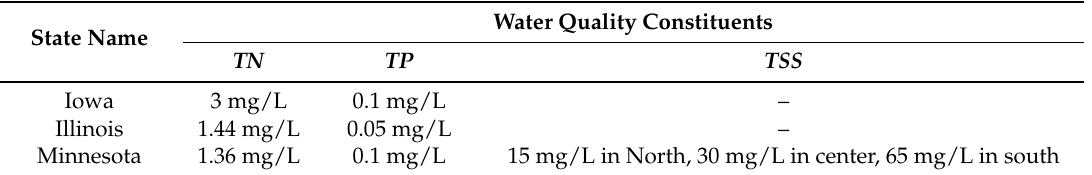
Table 2. Water quality criteria of different water quality constituents in three